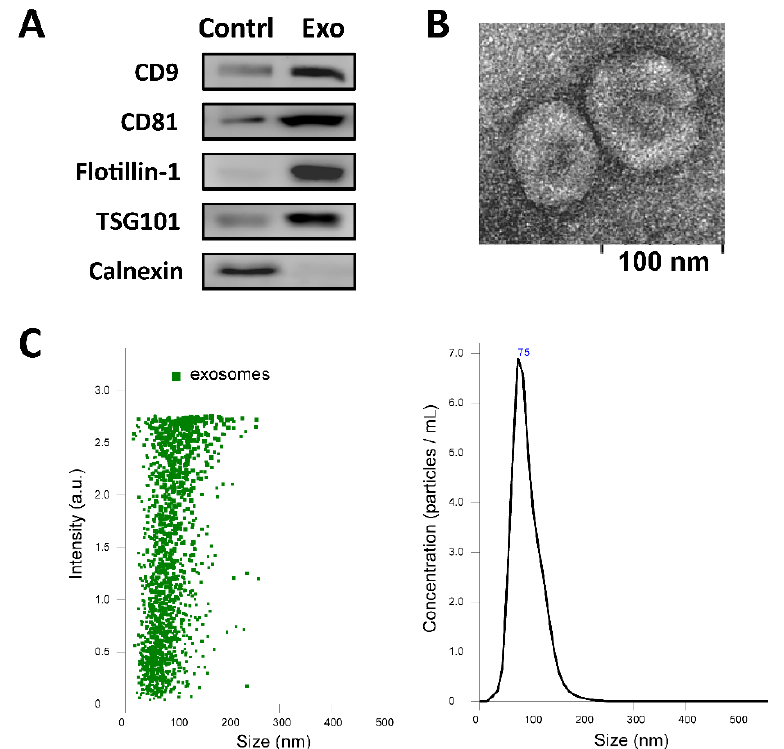
Figure 1. Characterization of isolated exosomes using ( A ) Western blotting for exosomal surface markers of the isolated exosomes (Exo) with cell lysate as the control (Contrl), ( B ) transmission electron microscope analyses, and ( C ) distribution of exosomes secreted by ADSCs and measurement of particle diameter by nanoparticle tracking analysis.